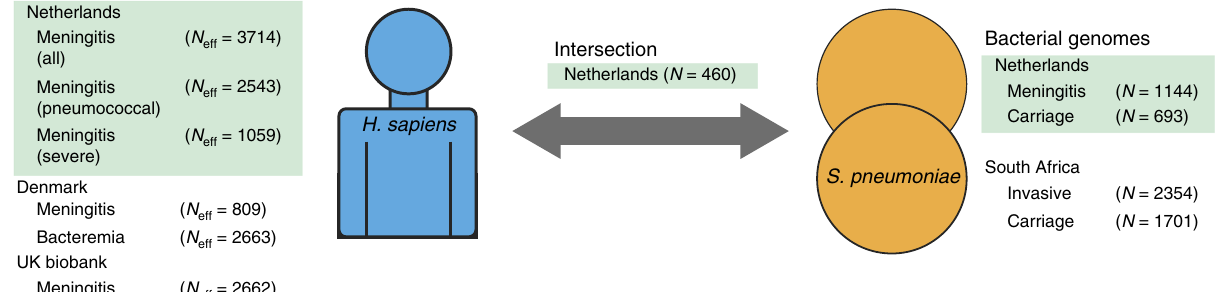
Fig. 1 Overview of cohorts sequenced and associations performed. Left, host data; right, bacterial data; the centre represents samples with both host and pathogen sequence data. Samples in green are those collected from our MeninGene cohort that form the centre of this work. Owing to unbalanced case – control ratios, we show the effective sample size, speci fi c numbers of cases and controls of human genotypes in Supplementary